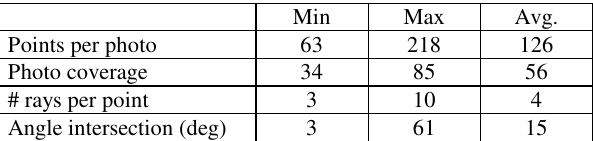
Table 10. Piazza Navona: block strength statistics.